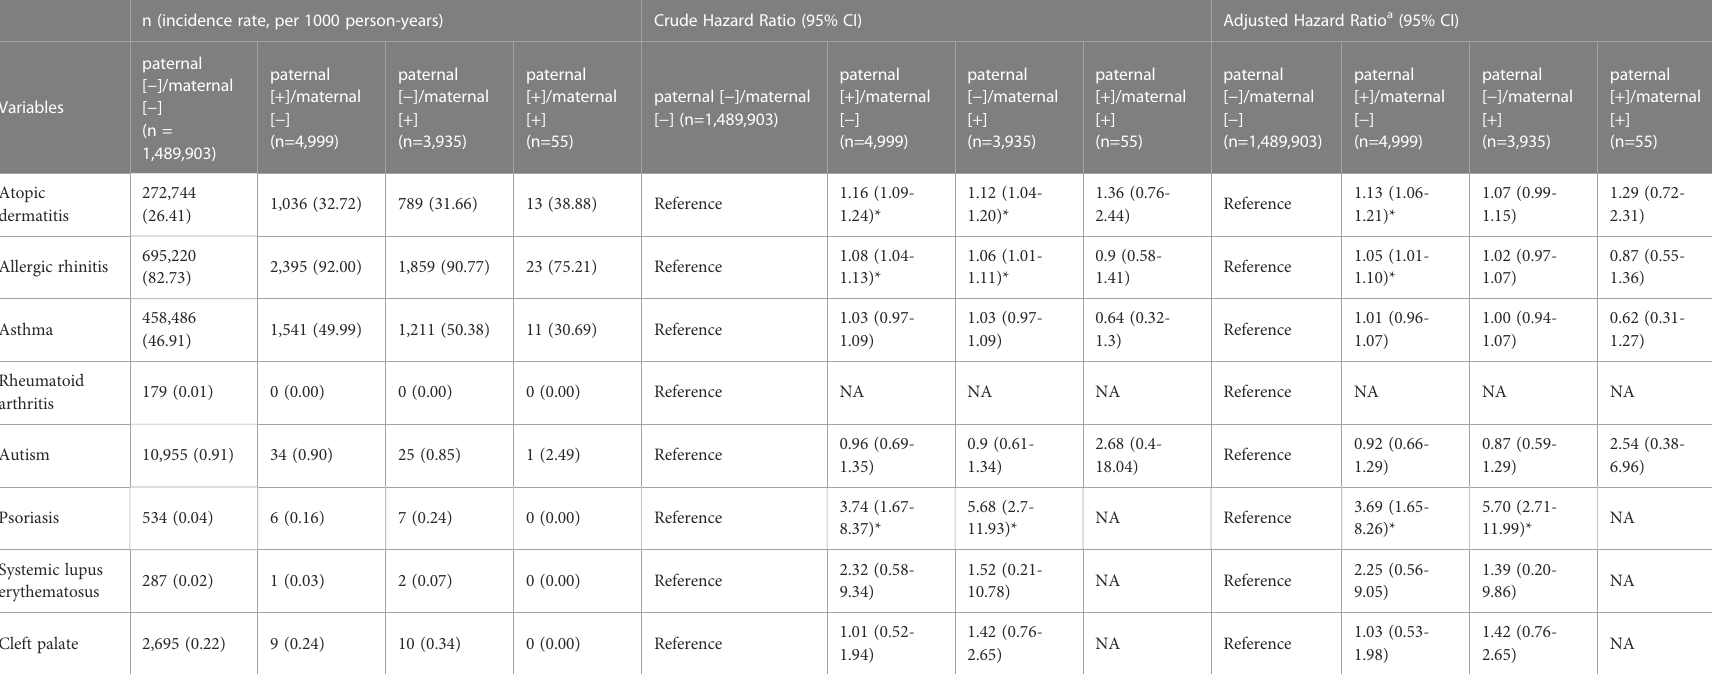
a Adjusted for maternal age, paternal age, infant sex, maternal Charlson comorbidity index, paternal Charlson comorbidity index, maternal nationality. *p<0.05. 95%CI: 95%Con fi dence interval; NA, not